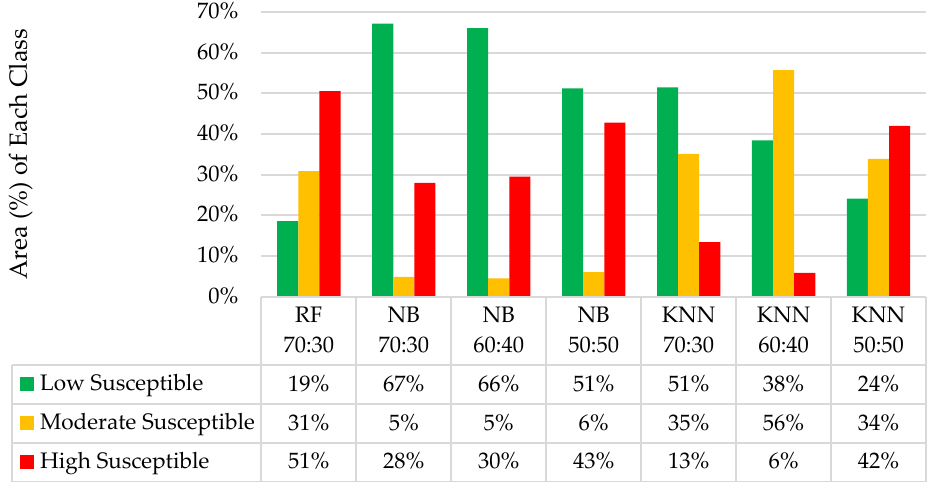
Figure 6. Landslide susceptibility classes’ percentages for each model.